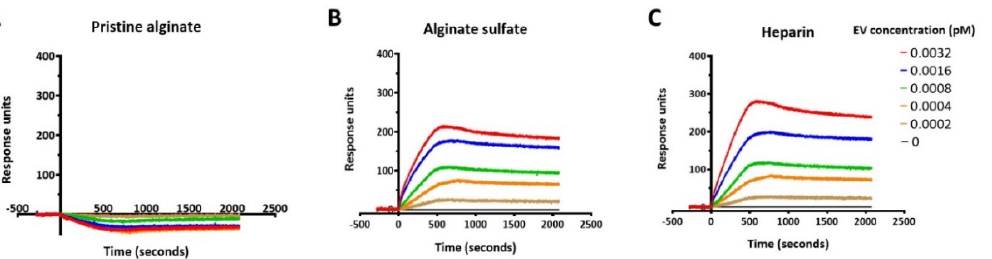
Figure 6. AlgS interacts with EVs through affinity binding. ( A – C ) Representative sensograms of different EVs concentrations with covalently bound pristine alginate ( A ), AlgS ( B ) and heparin ( C )